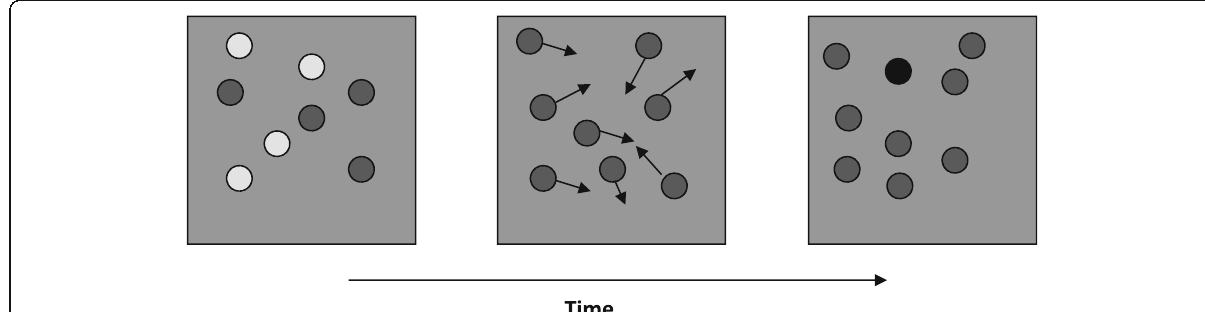
Fig. 1 Example display of experiment 1. The light grey disks in the first frame were yellow in the experiment proper and the black disk in the last frame was